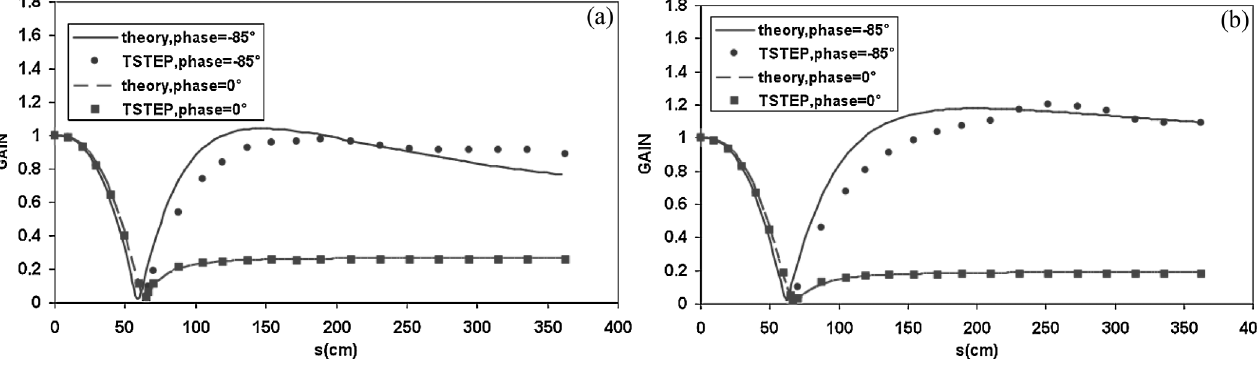
FIG. 12. Linear gain along the rf compressor for perturbation wavelengths (a) (cid:5) ¼ 200 (cid:12) m and (b) (cid:5) ¼ 250 (cid:12) m and two values of the initial rf